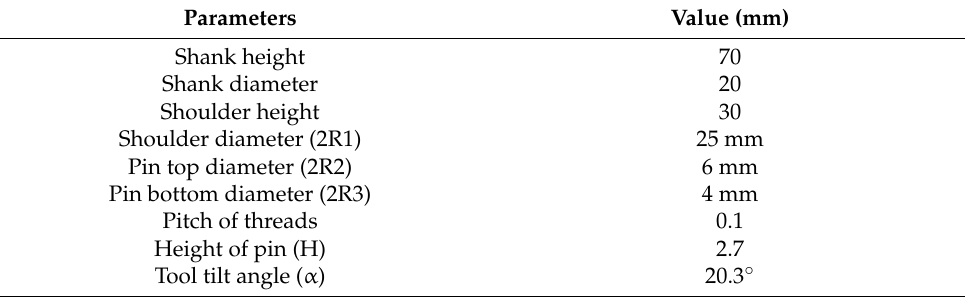
Figure 3. FSW tool geometry. Table 3. Dimension of FSW tool.